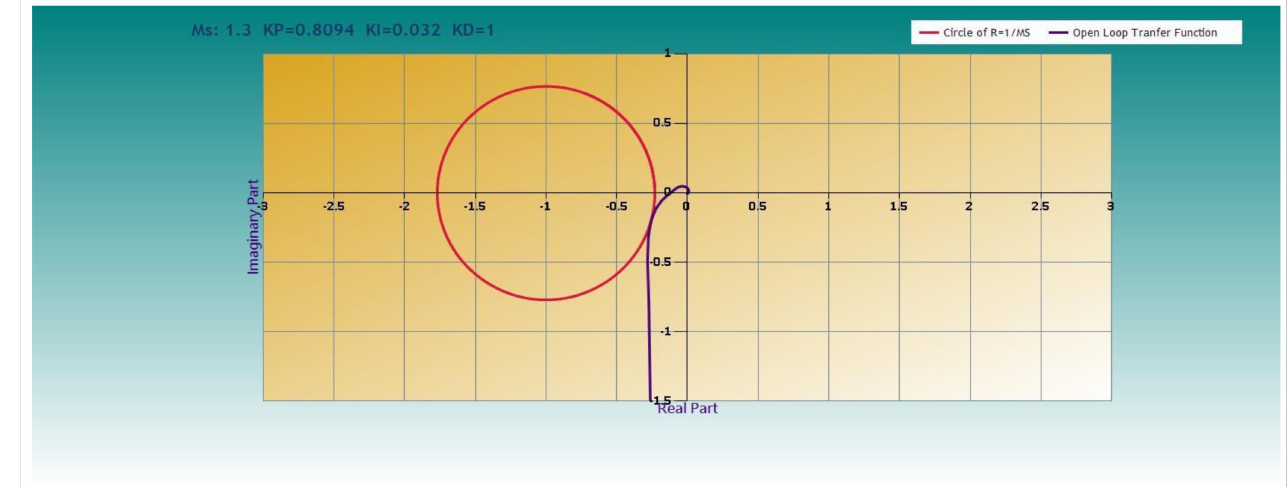
Figure 6. Nyquist curve of the open-loop transfer function for M s = 1.3 and k D =